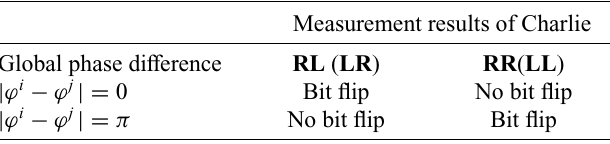
TABLE I. Postprocessing of the bit in the sifting step. In the X basis, Bob decides whether to implement a bit flip to guar- antee correct correlations, depending on the clicking detectors announced by Charlie and the global phase difference between two matching time bins. Here, RL ( LR ) denotes the detectors R ( L ) and L ( R ) clicks at time bins i and j , respectively;